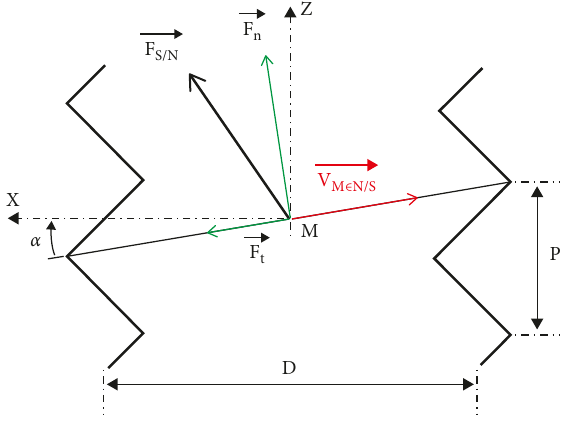
Figure 3: Stress analysis of drill pipe